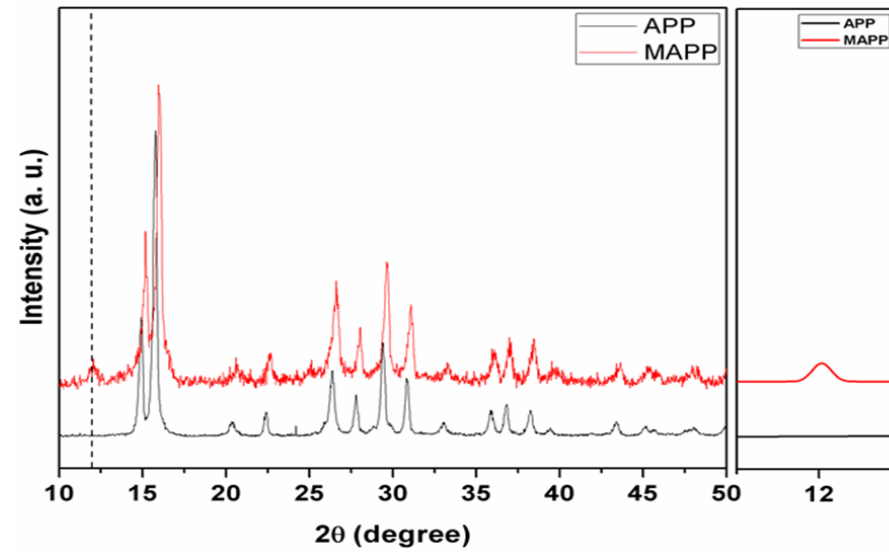
Figure 2. The XRD curves of APP and MAPP.